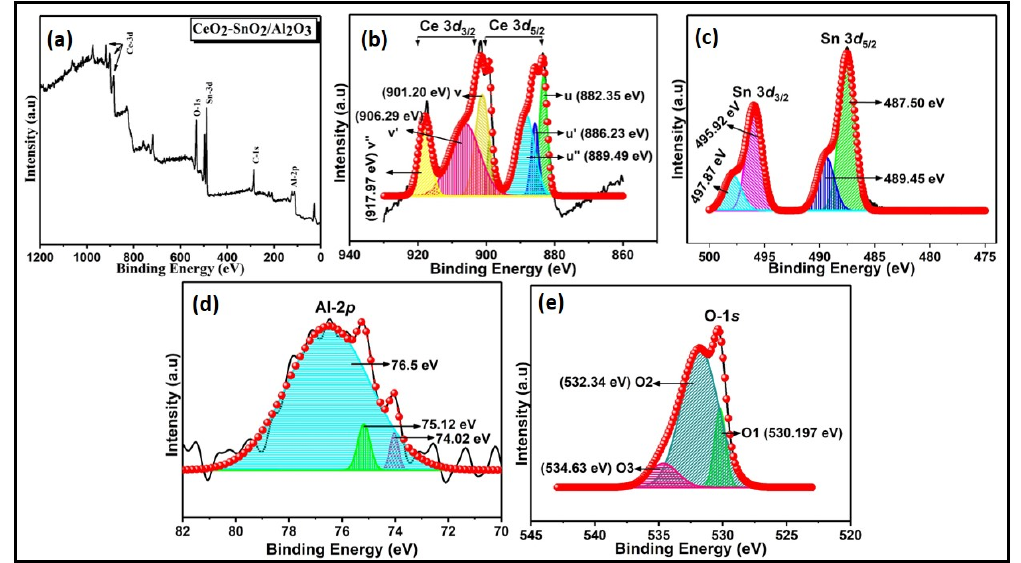
Figure 6. ( a ). XPS survey spectra of CTA-55 and ( b ) core-level spectra of Ce-3 d , ( c ) Sn-3 d , ( d ) Al-2 p , and ( e ) O-1 s .